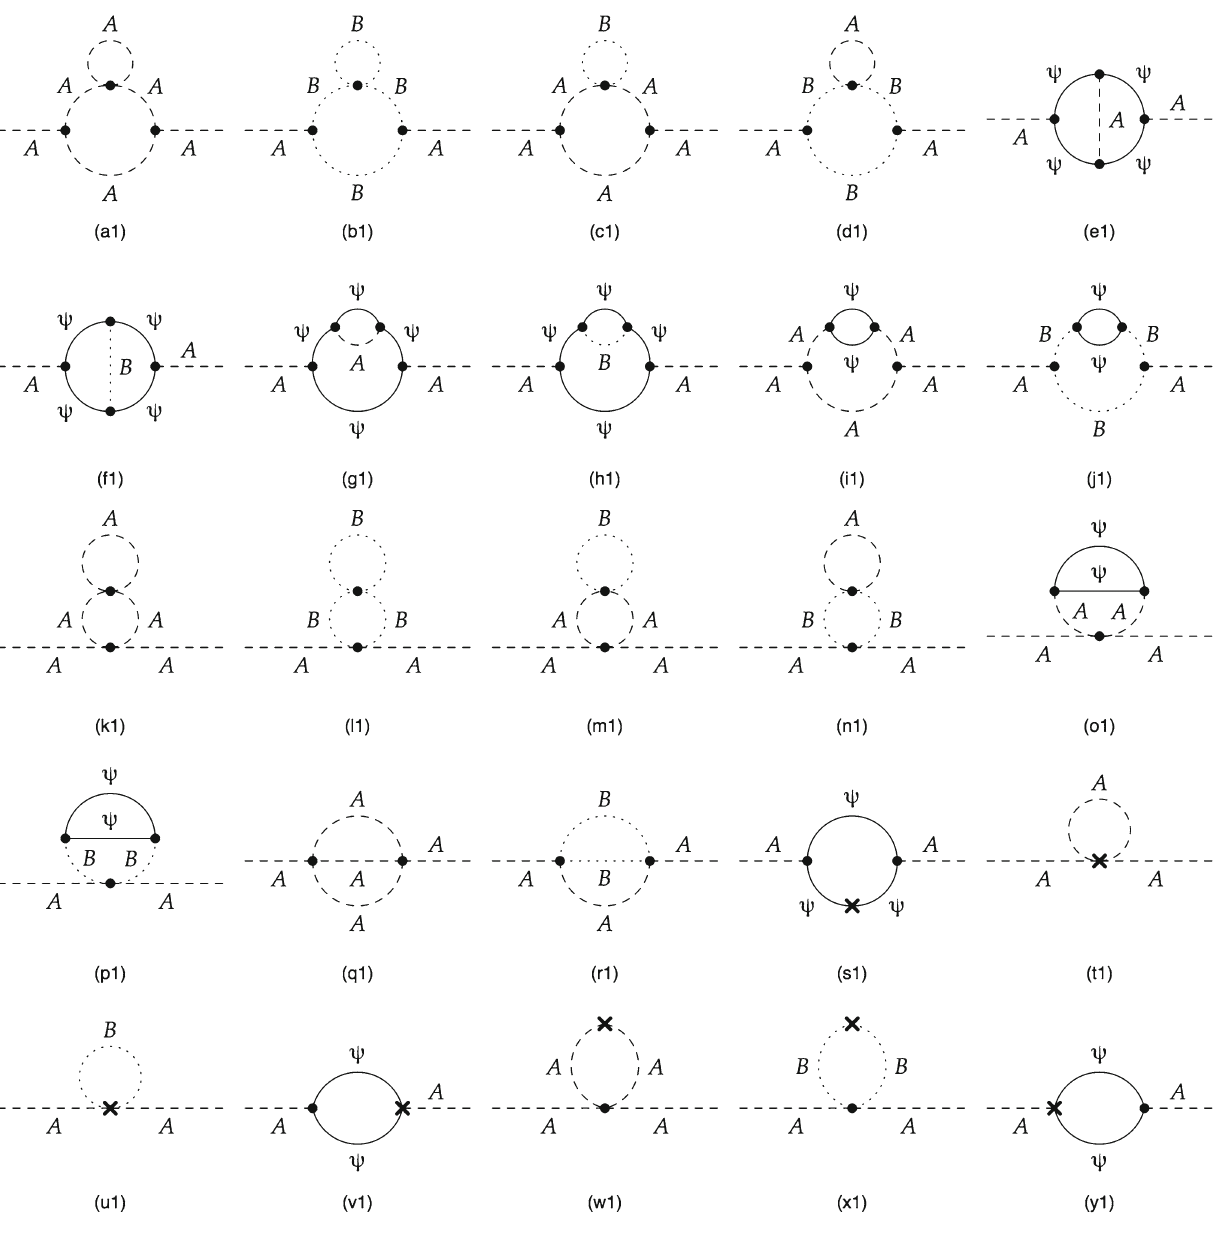
Fig. 2 Two-loop self-energy diagrams for scalar particle